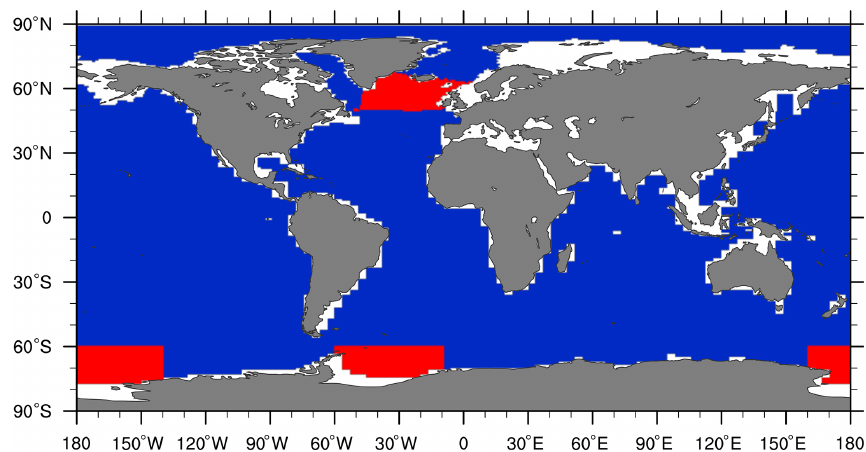
Figure 1. Regions allotted for the additional freshwater forcing (shown in red). Additional 0.1Sv in total was uniformly given to the specified region in the North Atlantic for expLGMws, while, for expLGMss, 0.1 and 0.25Sv were subtracted from the North Atlantic and Southern Ocean, respectively. Corresponding compensation (i.e. freshwater flux having the opposite sign) was applied to the other regions homogeneously to keep the total volume of seawater